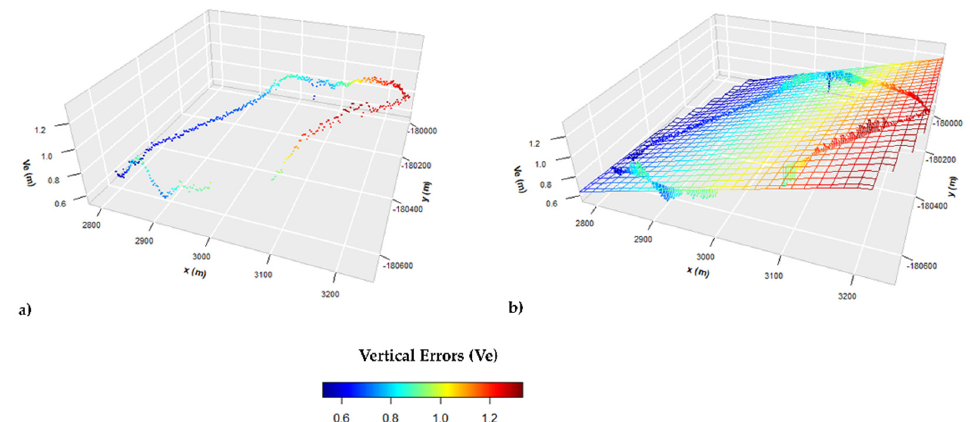
Figure 12. 3D scatterplots: vertical errors in metres for each unchanged area elevation profile ( a ) and a fitting plane performed through a planar regression of these errors on a 30-metre grid ( b ). In these plots, only the elevation points with a distance of 3 m from each other were represented, resulting in 534 points out of a total of 20,124.